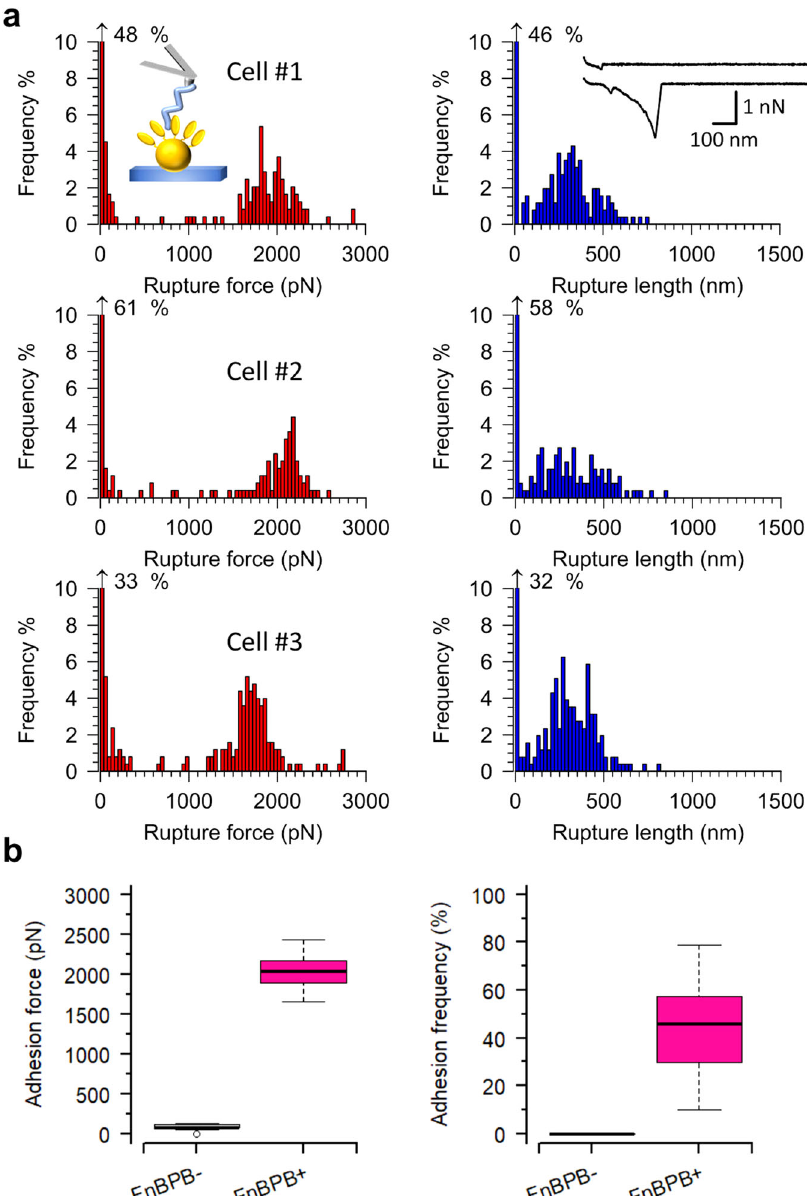
Fig. 2 Strength of single interactions between FnBPB and loricrin. AFM tips modi fi ed with loricrin were used to probe single exponentially grown staphylococcal cells induced to express FnBPB. a Data for three representatives S. aureus SH1000 4X (pFnBPB) cells. Left. Histogram plots of rupture forces. Right. Histogram plots of rupture lengths with inset in the fi rst cell showing representative curves. b Boxplots of adhesion forces and frequencies for S. aureus SH1000 4X (pALC2073) cells [FnBPB − ] and S. aureus SH1000 4X (pFnBPB) cells [FnBPB + ]. Whiskers show the range, the boxes the interquartile range, the thick lines within the boxes the median and open circles outliers. The differences in adhesion force ( P = 1.3 × 10 − 5 ) and frequency ( P = 1.6 × 10 − 6 ) between the FnBPB − and FnBPB + cells were tested using a two-sided Mann – Whitney U